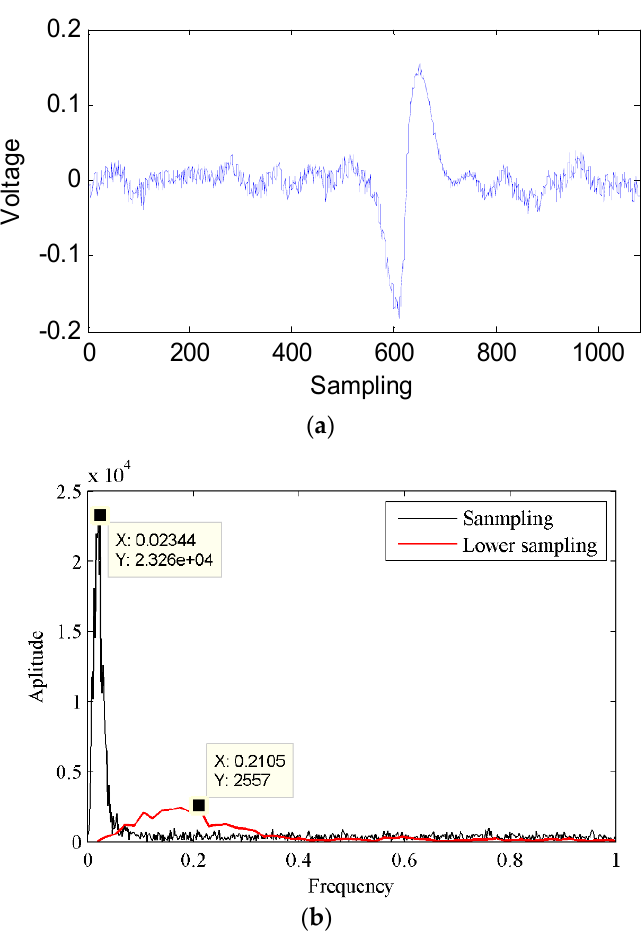
Figure 9. ( a ) A defect balanced signal block of one channel; ( b ) spectrums of primary sampling and down-sampling.